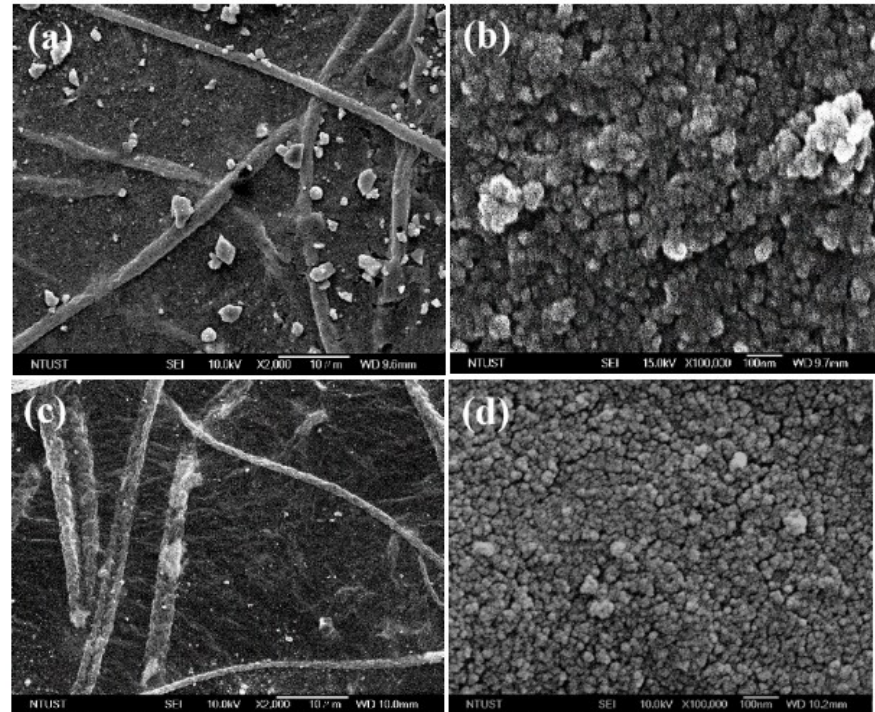
Figure 3. FESEM micrographs of the TiO 2 nanofilm deposited by electrophoresis on GO/rTAC film: ( a , b ) 30 V TiO 2 /30 V GO/rTAC at different magnifications and ( c , d ) 50 V TiO 2 /30 V GO/rTAC at different magnifications.